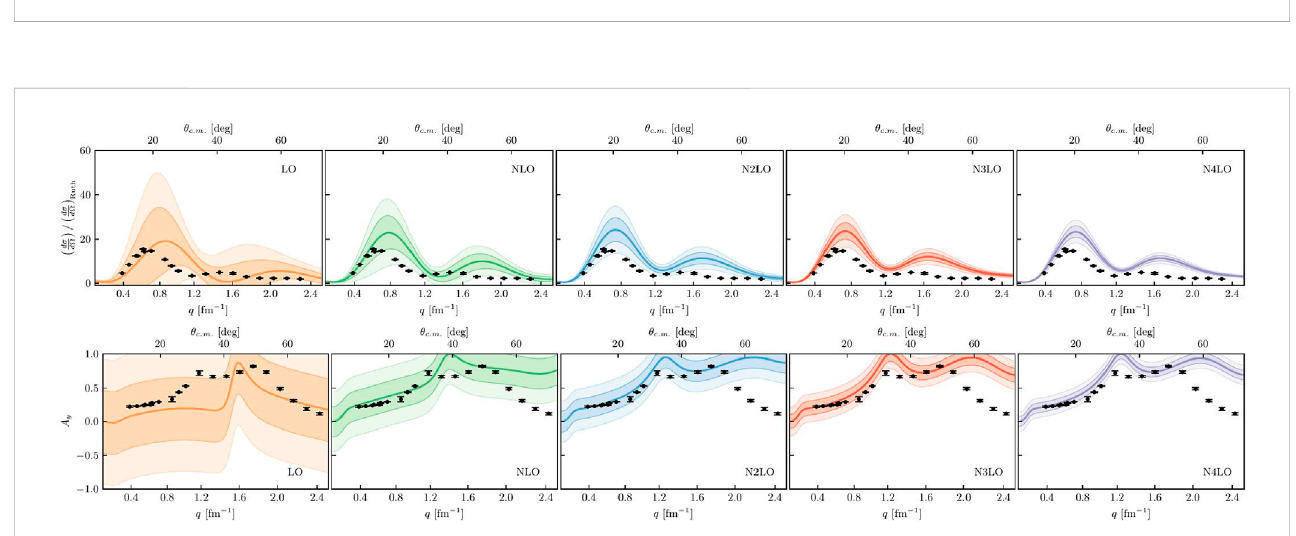
FIGURE 9 Analyzing power for proton scattering on 16 O at ( fi rst row) 65 MeV, (second row) 100 MeV, and (third row) 135 MeV for LO (left column), NLO (middle column), and N2LO (right column) with corresponding 1 σ (darker bands) and 2 σ (lighter bands) error bands. Black dots are experimental data from Ref. [85]